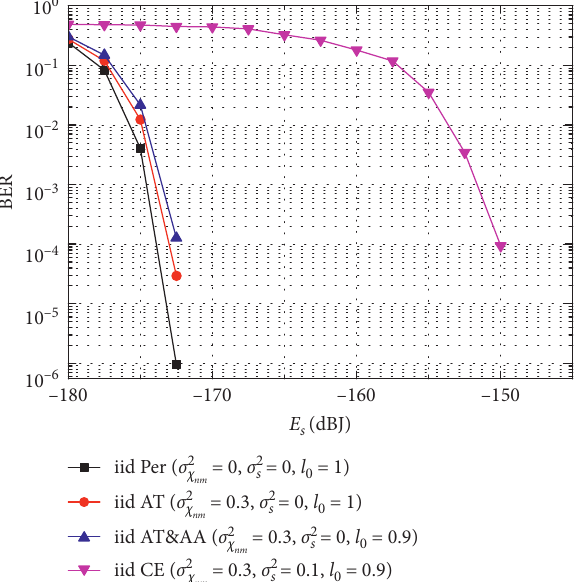
Figure 3: BER of different conditions over independent channel in a 2 × 2 MIMO